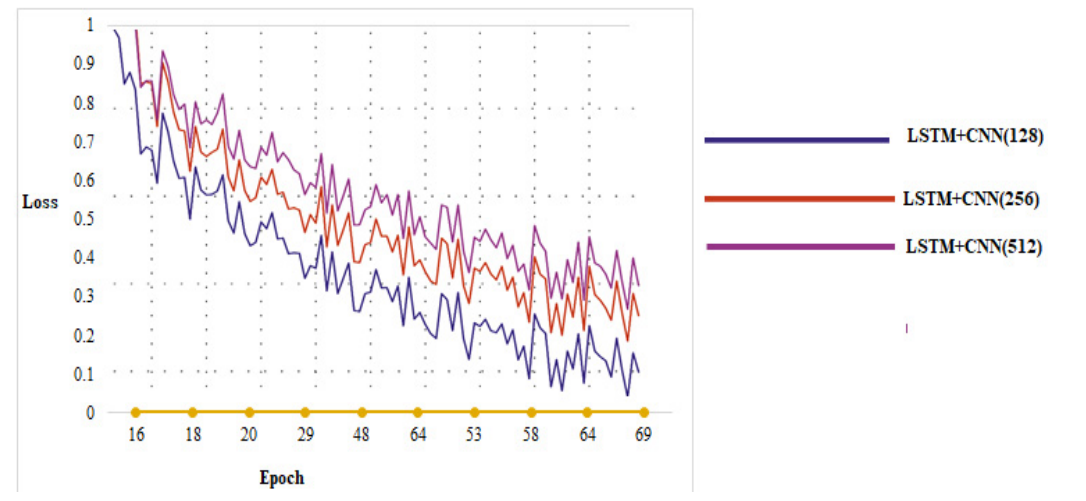
Figure 15. Study of the parameter ( α ) of training loss.